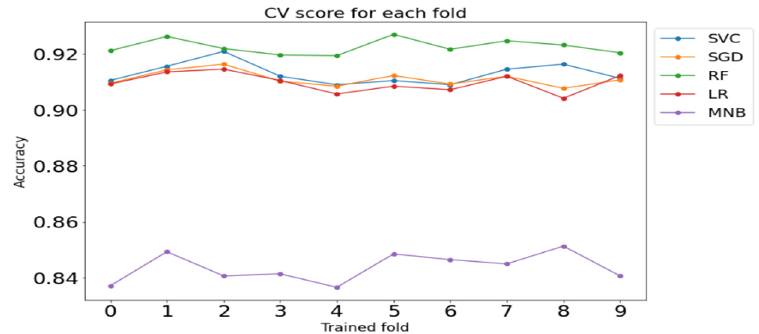
Figure 8. 10-fold Cross-Validation for each ML model.